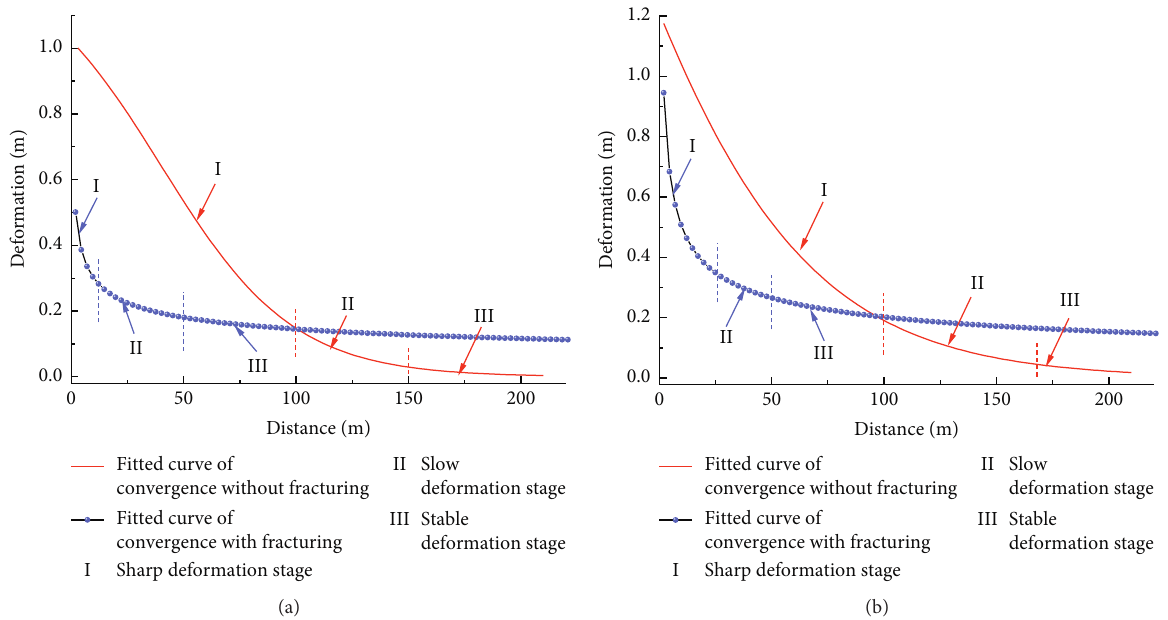
Figure 11: Comparison of fitted curves of the roadway deformations in the fracturing area and nonfracturing area. (a) Deformation results of the roof to floor convergence. (b) Deformation results of two sidewalls